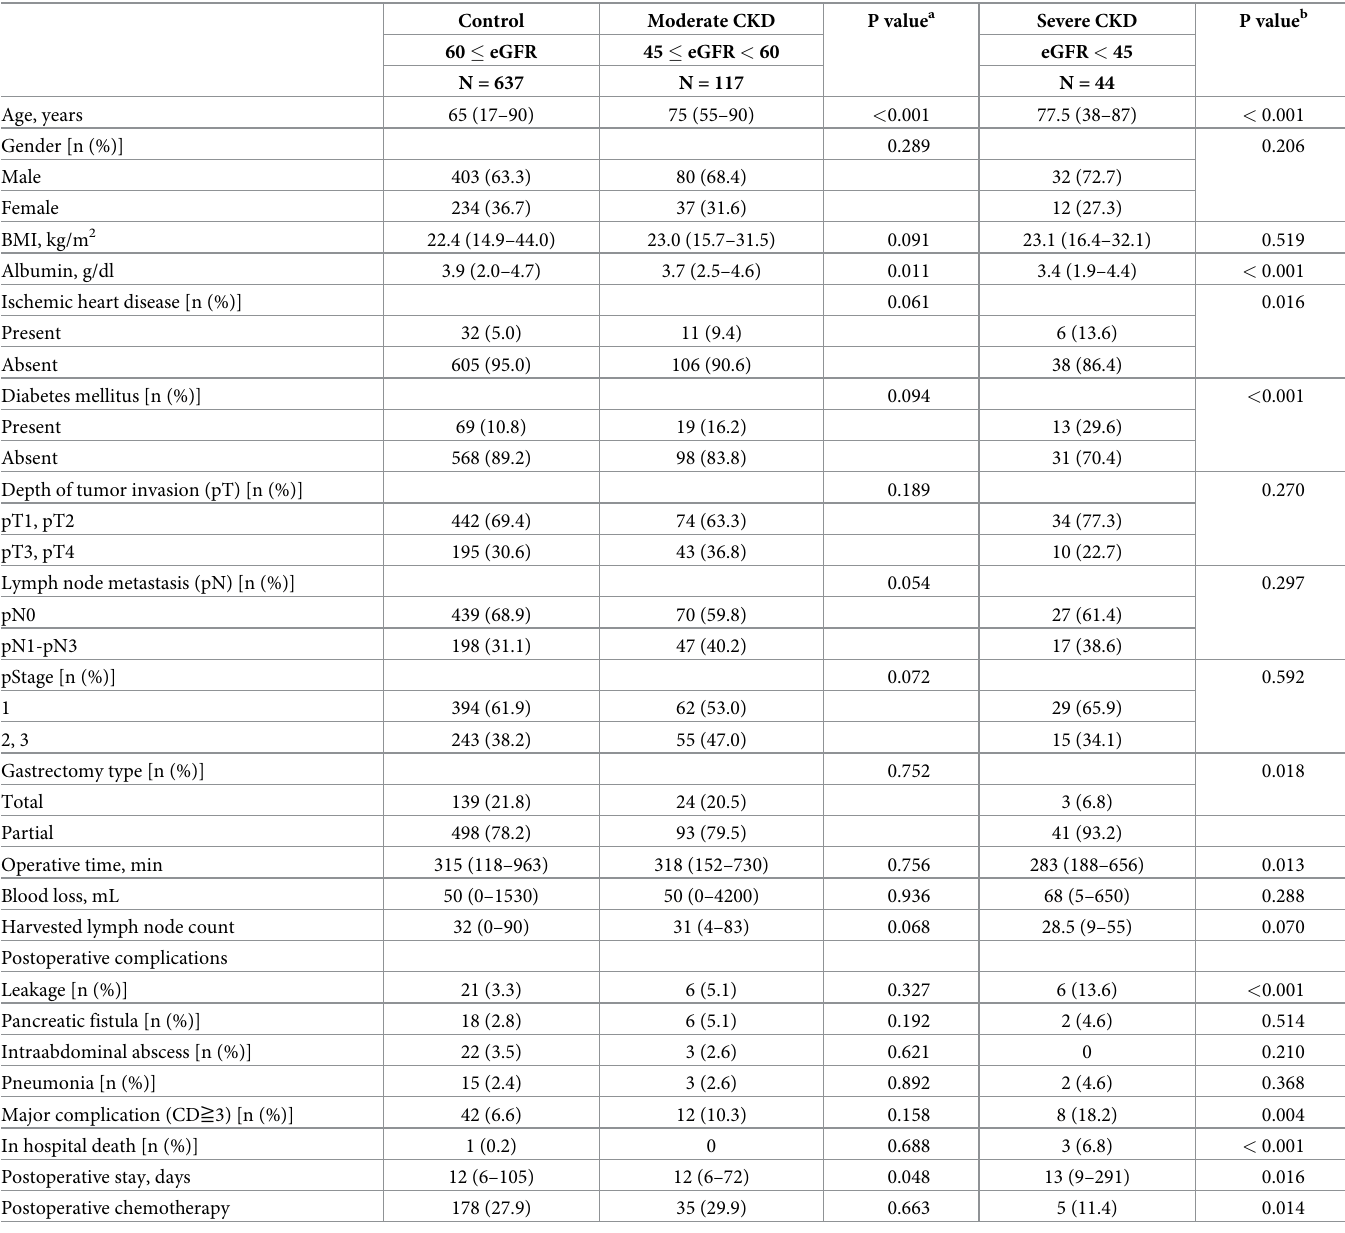
Table 1. Clinicopathologic variables in each CKD